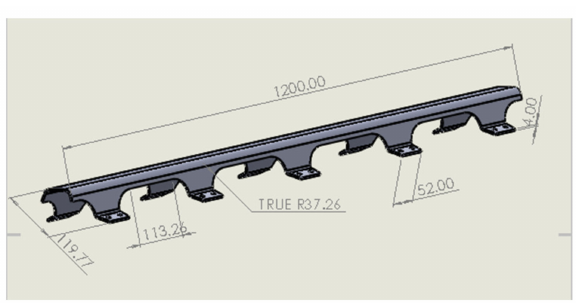
Figure A7. Top cover (Dimensions in